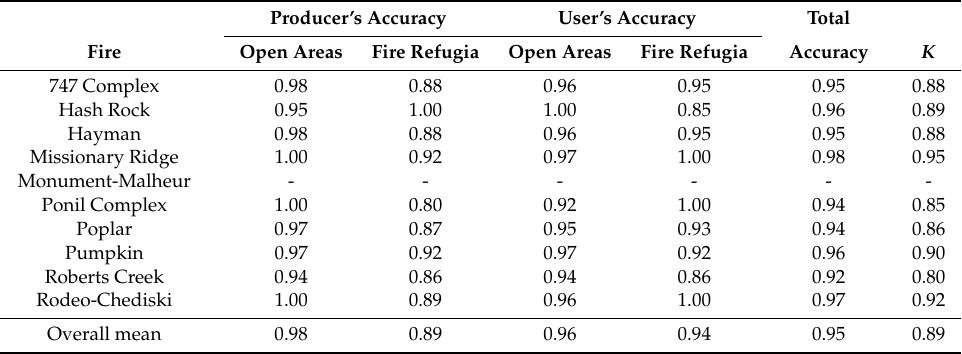
Table 3. Ground truth accuracy assessments from confusions matrices computed for each